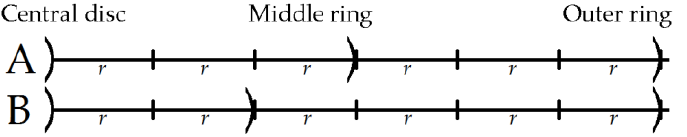
Figure 5. Relative locations of rings with respect to the central disc for CIRD ( A ) and LIIRD ( B ) NDM based TCRE configurations.